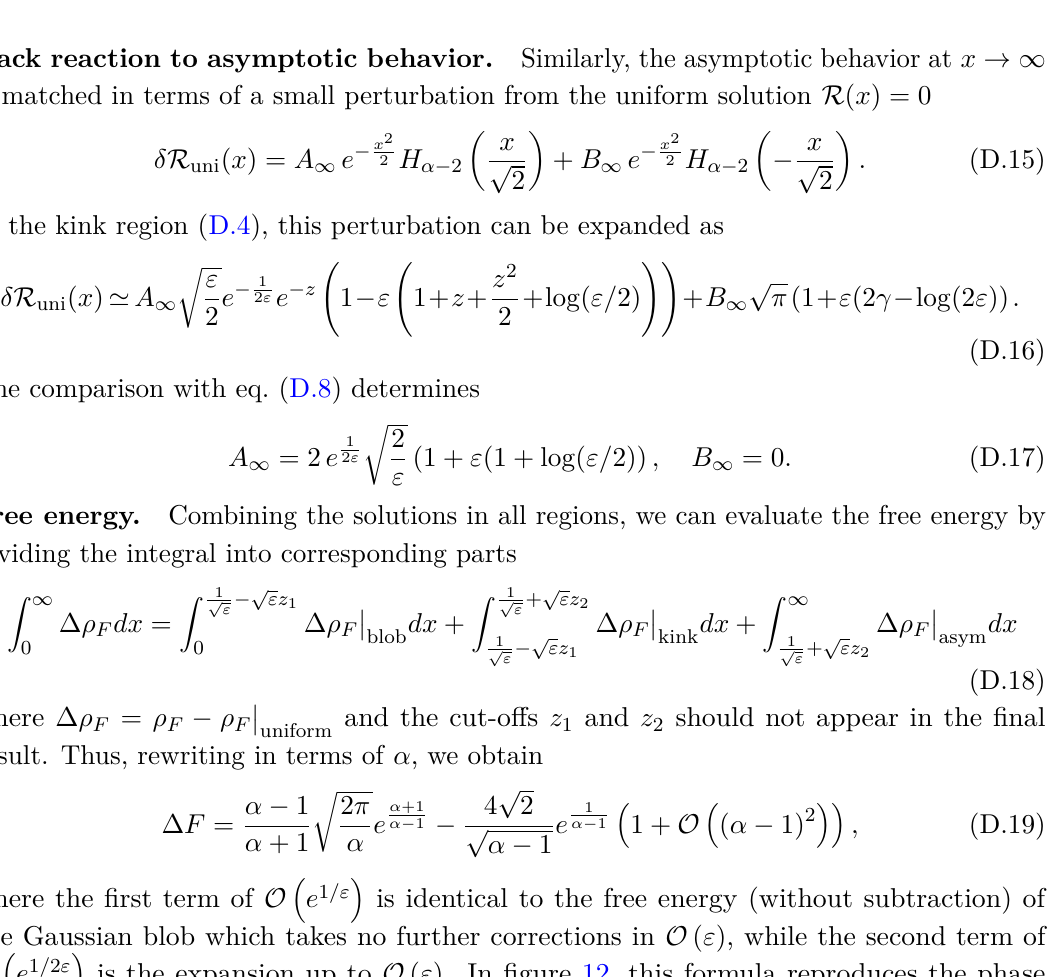
Figure 12 . Bulge branches at large deformation. The dashed curve is the approximation by the blob and kink construction